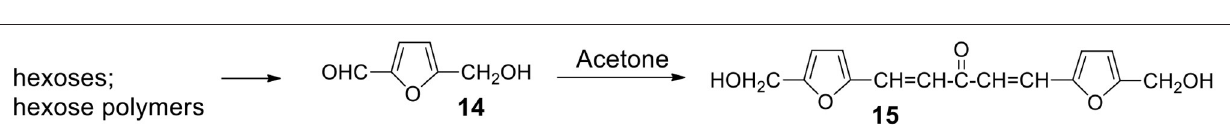
groups that can be acylated or alkylated. Depending on the character of introduced substituents (hydrophilic or hydrophobic) the products can be either soluble or insoluble in